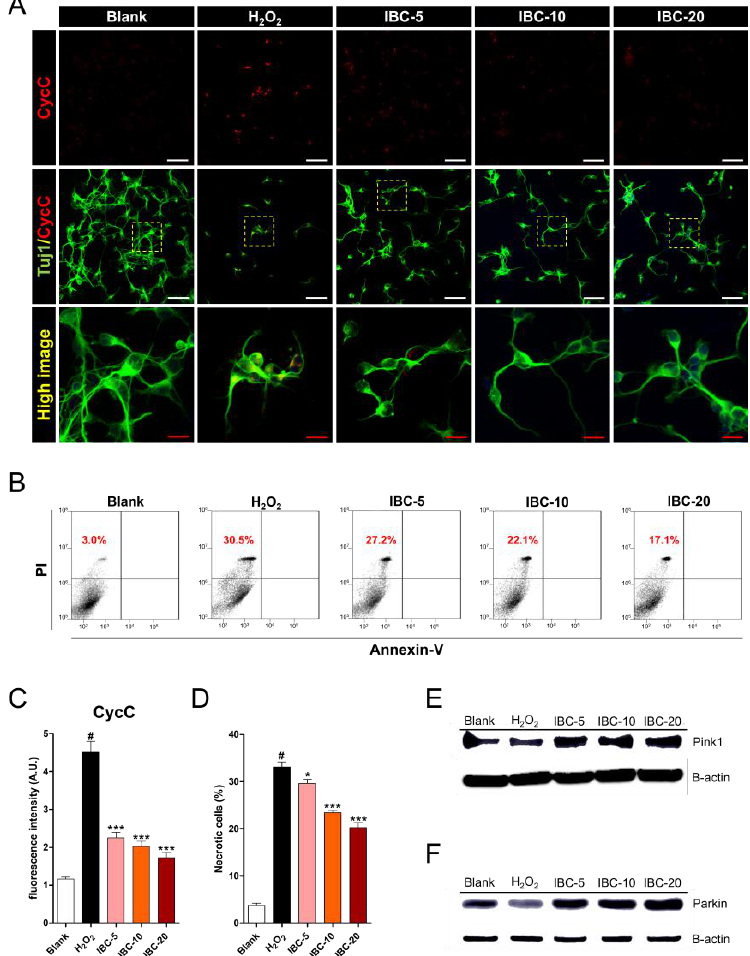
Figure 7. Effect of IBC extract on cell death following H 2 O 2 -induced oxidative stress injury of rat primary cortical neurons. ( A ) Representative images of low and high anti-cytochrome c (CycC) staining. White scale bar = 50 µm, Red scale bar = 15 µm. ( B ) Flow cytometric dot plots showing annexin V (X-axis) and propidium iodide (Y-axis) staining of cortical neurons. ( C ) The relative fluorescence intensity of anti-CycC on each low magnified image in five groups (n = 6). ( D ) The percentage of necrotic cells for annexin V-/PI+ from flow cytometric immunofluorescence (n = 5). ( E, F ) Western blot analysis of pink1 and parkin in IBC-treated neurons with H 2 O 2 exposure. Data are expressed as the means ± SEM. Significant differences indicated as # p < 0.001 compared vs. the blank group, * p < 0.05 and *** p < 0.001 vs. the H 2 O 2 group were analyzed via one-way ANOVA with Tukey’s post hoc test.